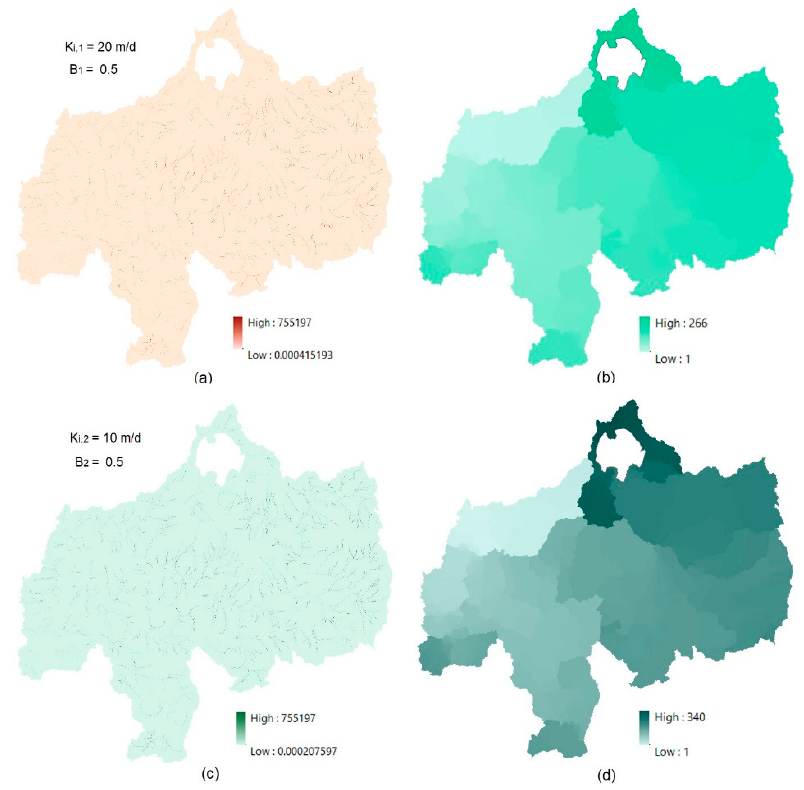
Figure 5. GIS grid-based calculations of arrival time grid of Upper Groundwater Aquifer. ( a ) Vg (1) Grid (m / d); ( b ) Tg (1) Grid ( d ), and Lower Groundwater Aquifer. ( c ) Vg (2) Grid (m / d); ( d ) Tg (2) Grid ( d ).